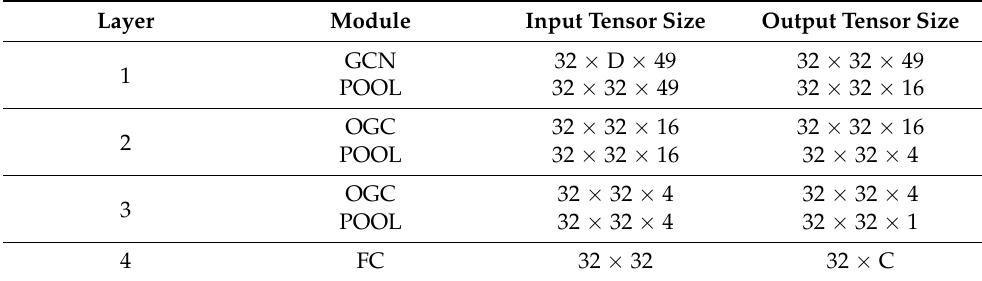
Table 1. Configuration of Deep Network Used in Graph